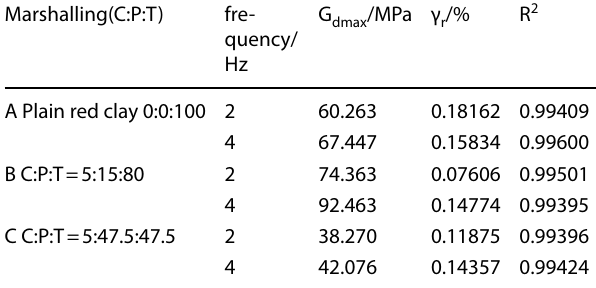
Table 9 Fitting parameters and correlation coefficients of dynamic shear modulus at different frequencies